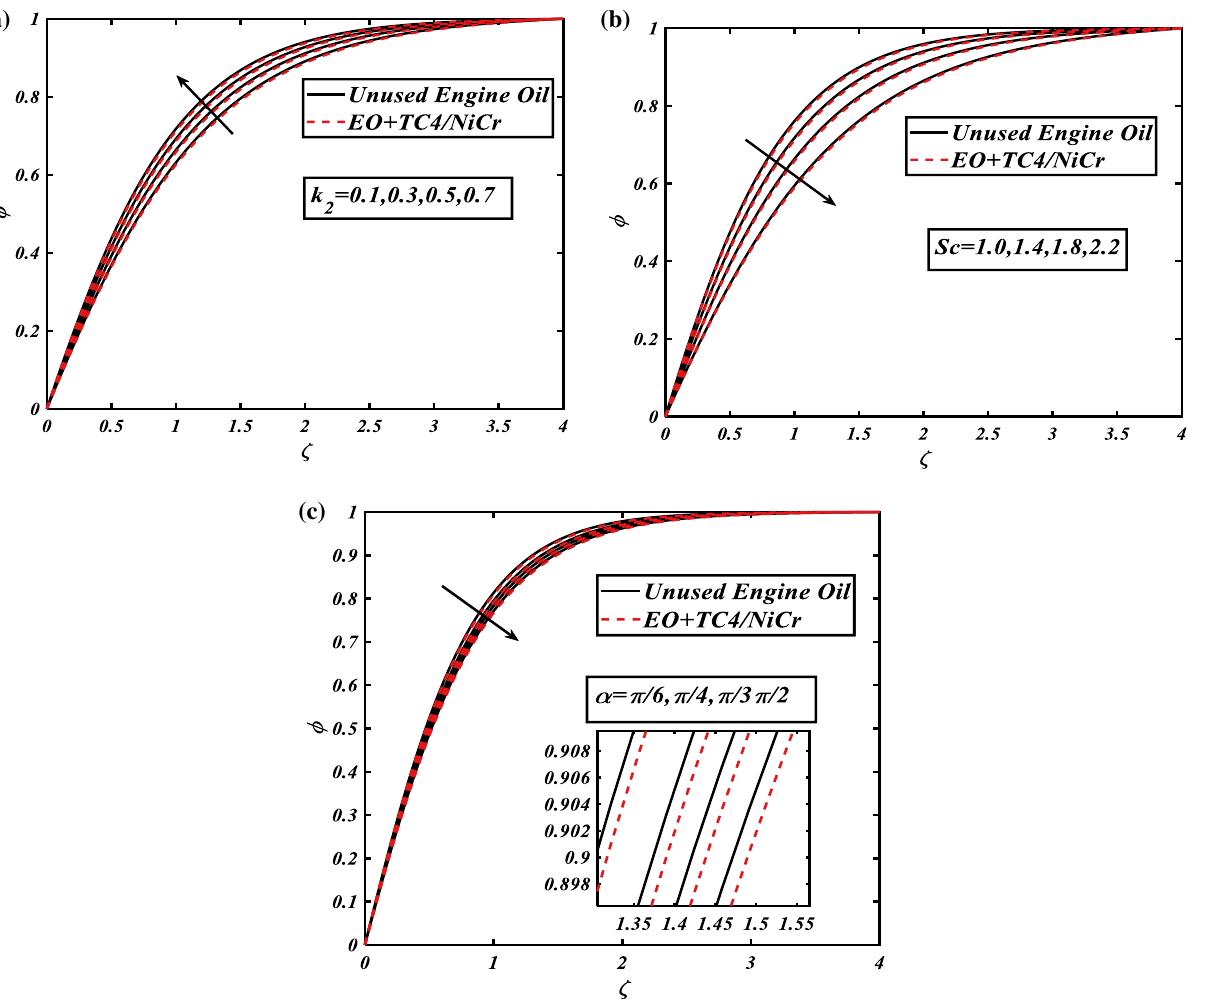
Figure 5. ( a ) Graphical illustration of concentration φ against k 2 . ( b ) Graphical illustration of concentration φ against Sc . ( c ) Graphical illustration of concentration φ against α